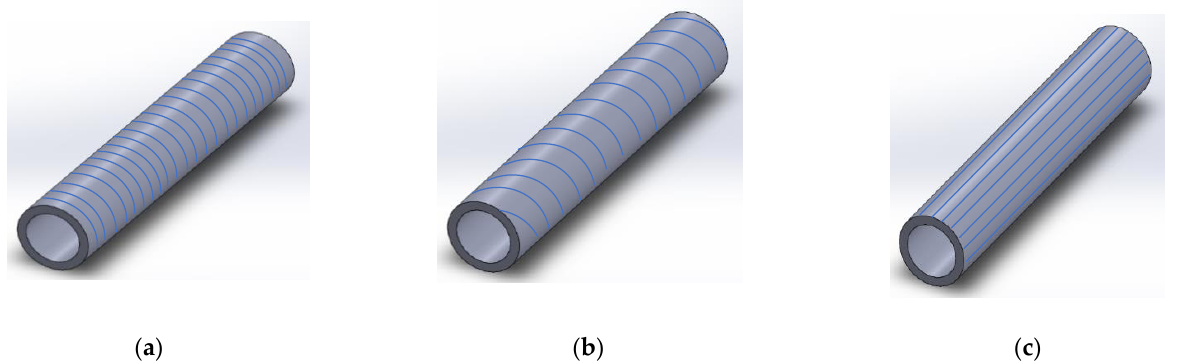
Figure 6. Illustration of layer orientation within the samples which were printed using different printing angles: ( a ) 0°; ( b ) 45°; ( c ) 90°.